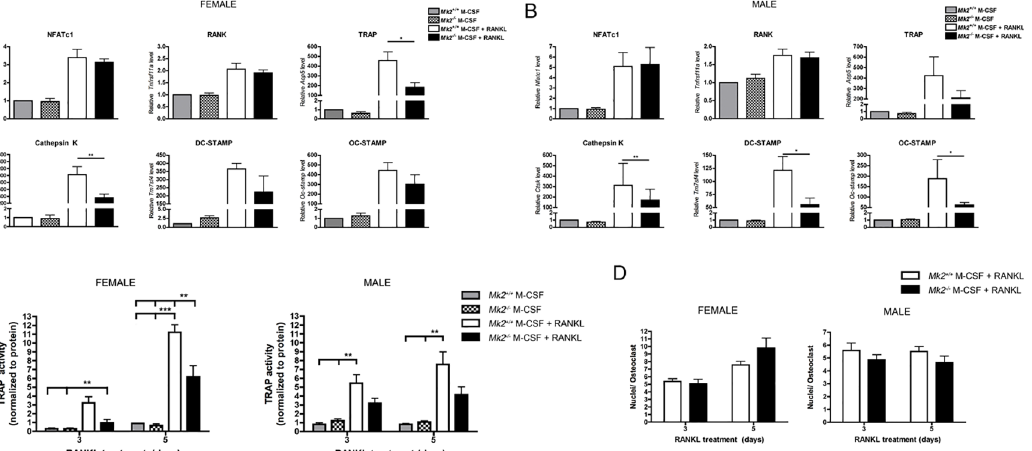
Fig 5. MK2 signaling regulates osteoclast fusion genes from male mice during osteoclast maturation. (A-D) Cells were treated as in Fig 1 for three days. Gene expression was determined by RT-qPCR in osteoclasts from (A) female and (B) male mice. (C) TRAP activity was assessed in female (left) and male (right) osteoclasts on day 3 and 5 post M-CSF and RANKL stimulation using the Takara TRACP Kit. (D) Nuclei were enumerated in female (left) and male (right) in osteoclasts, defined as TRAP positive cells with three or more nuclei. Data are expressed as means ± SE ( * P (cid:1) 0.05, ** P (cid:1) 0.01, *** P (cid:1) 0.001).